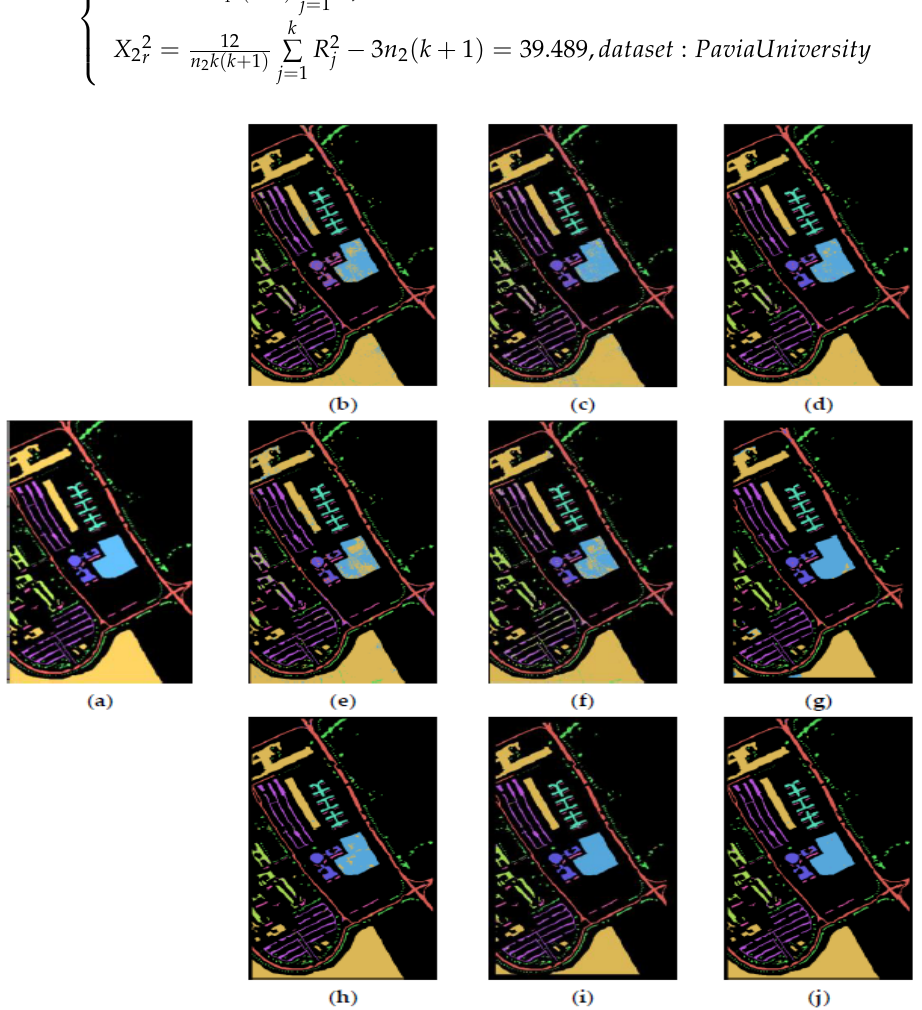
Figure 17. The ground truth and classification maps of the nine models on the Pavia University dataset. ( a ) The ground truth. ( b ) SVM. ( c ) RNN. ( d ) ANN. ( e ) 1D CNN. ( f ) SF. ( g ) 3D CNN. ( h ) Hamida. ( i ) HybridSN. ( j ) ESFNet.